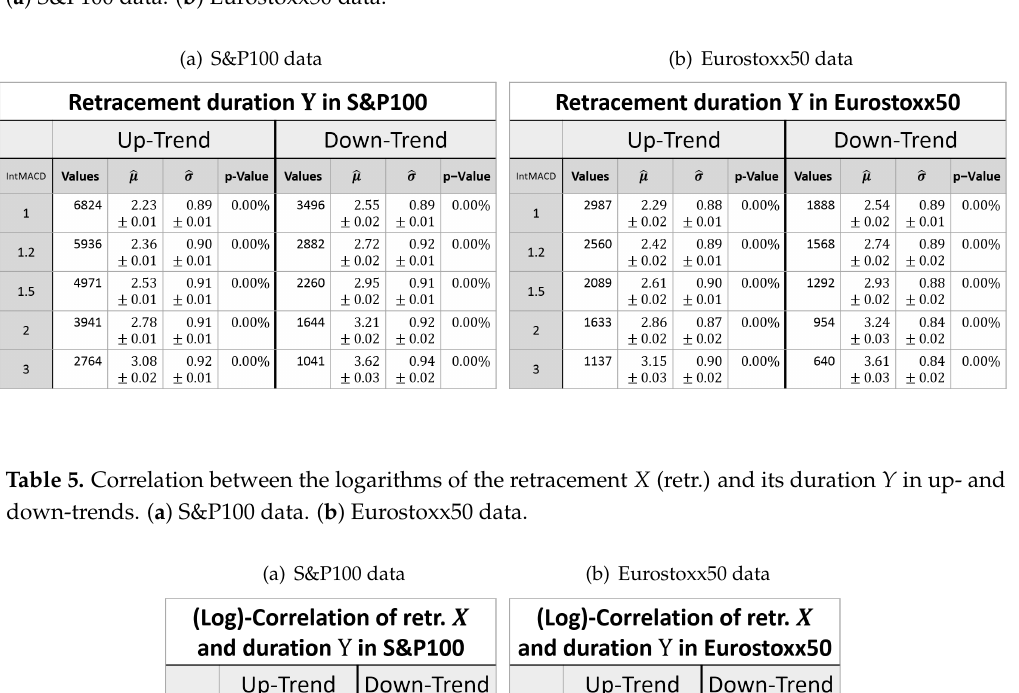
Table 4. Parameters of the log-normal fit for the retracement duration in up- and down-trends.